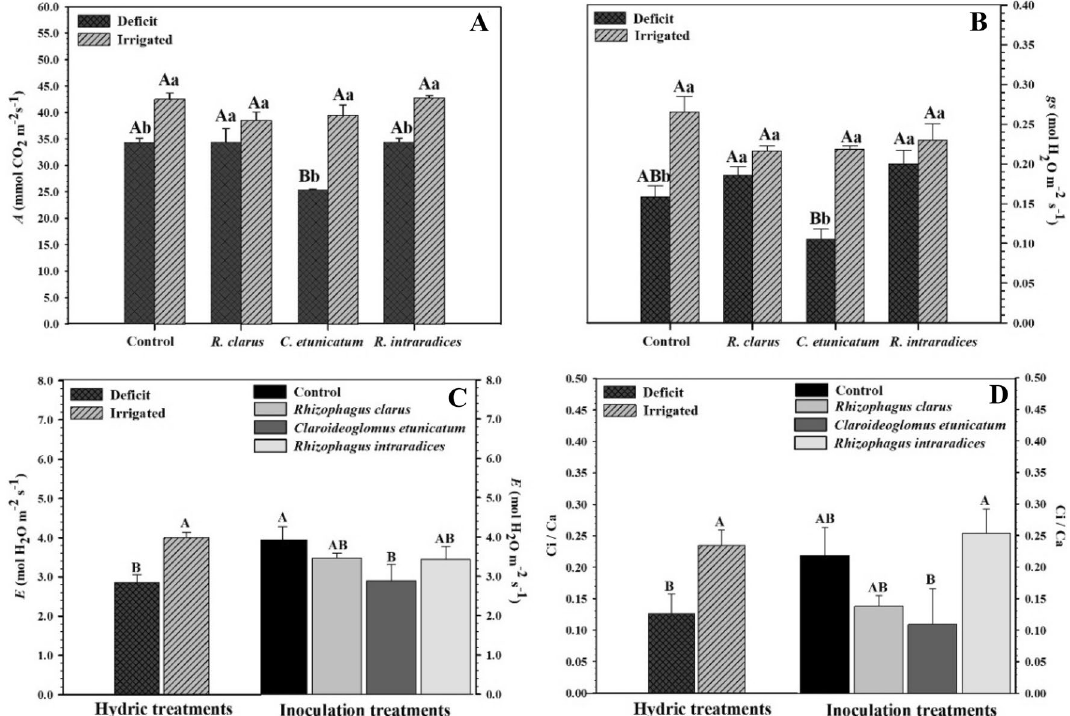
Figure 2. Photosynthetic rate ( A ), stomatal conductance ( B ), transpiration ( C ), and internal and external concentrations of CO 2 ( D ) of corn plants (Zea mays) submitted to different water treatments and inoculated with AMF after reirrigation. The bars represent the mean ± standard error of the mean (SEM) ( n = 4). Means followed by the same letter, uppercase among inoculation treatments and lowercase between water treatments, do not differ ( p > 0.05) among themselves by Tukey’s